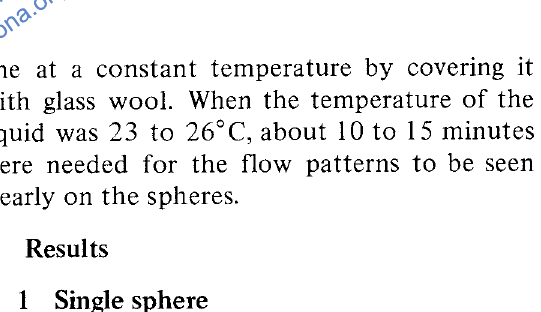
Fig. 5 Measured results of separation angle, - : Taneda 5 l 1956